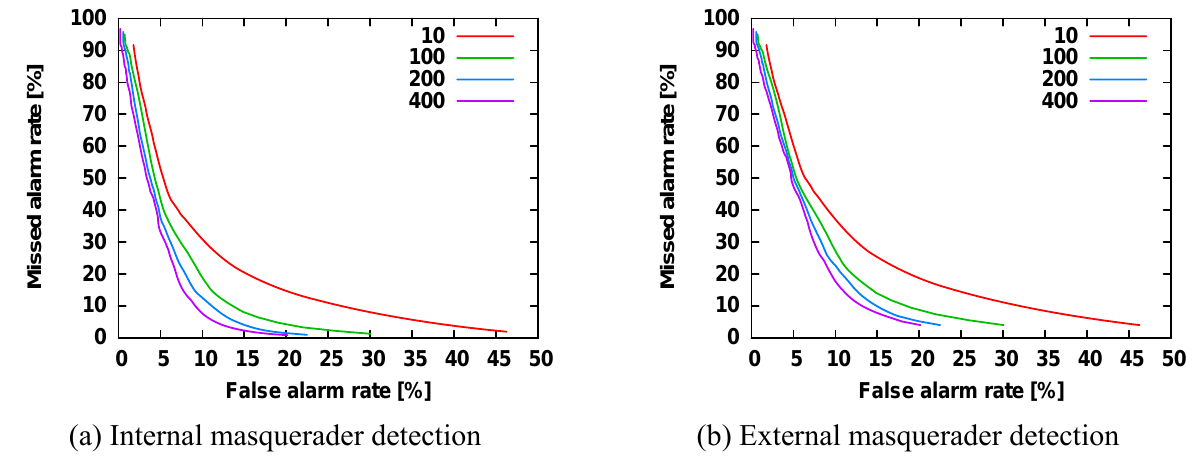
Figure 10. ROC curves for detection of internal masqueraders (a) and external masqueraders (b) according to the length of test sequences. All other parameters are the same as those in Figure 3.